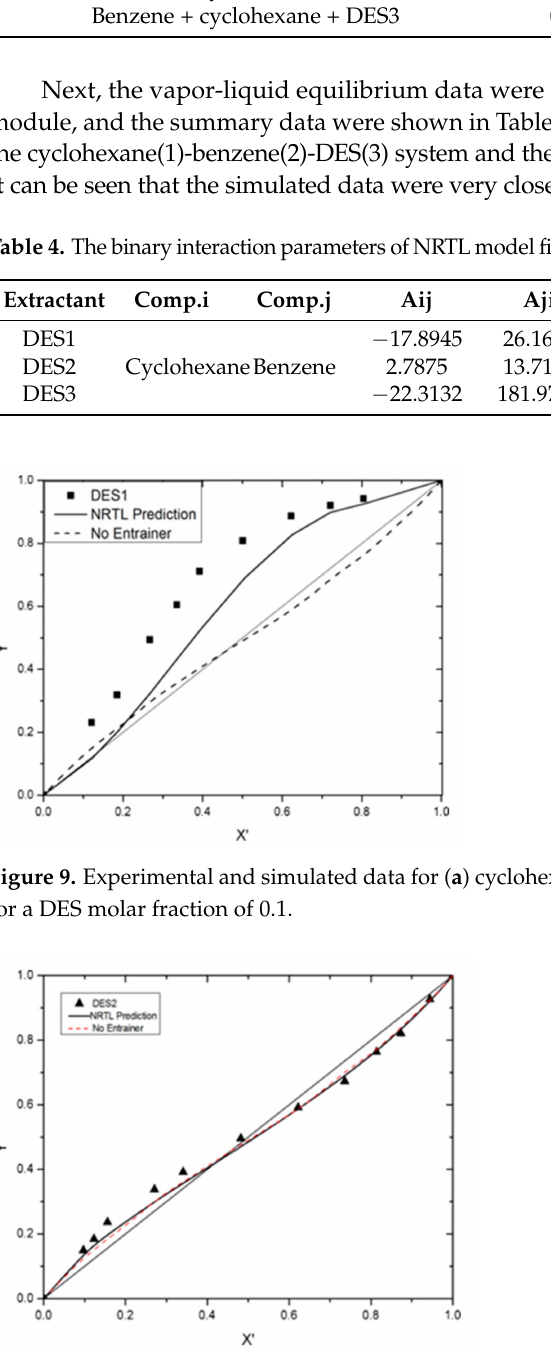
Figure 10. Experimental and simulated data for ( a ) cyclohexane, ( b ) benzene and ( c ) DES2 at 101.3 kPa for a DES molar fraction of